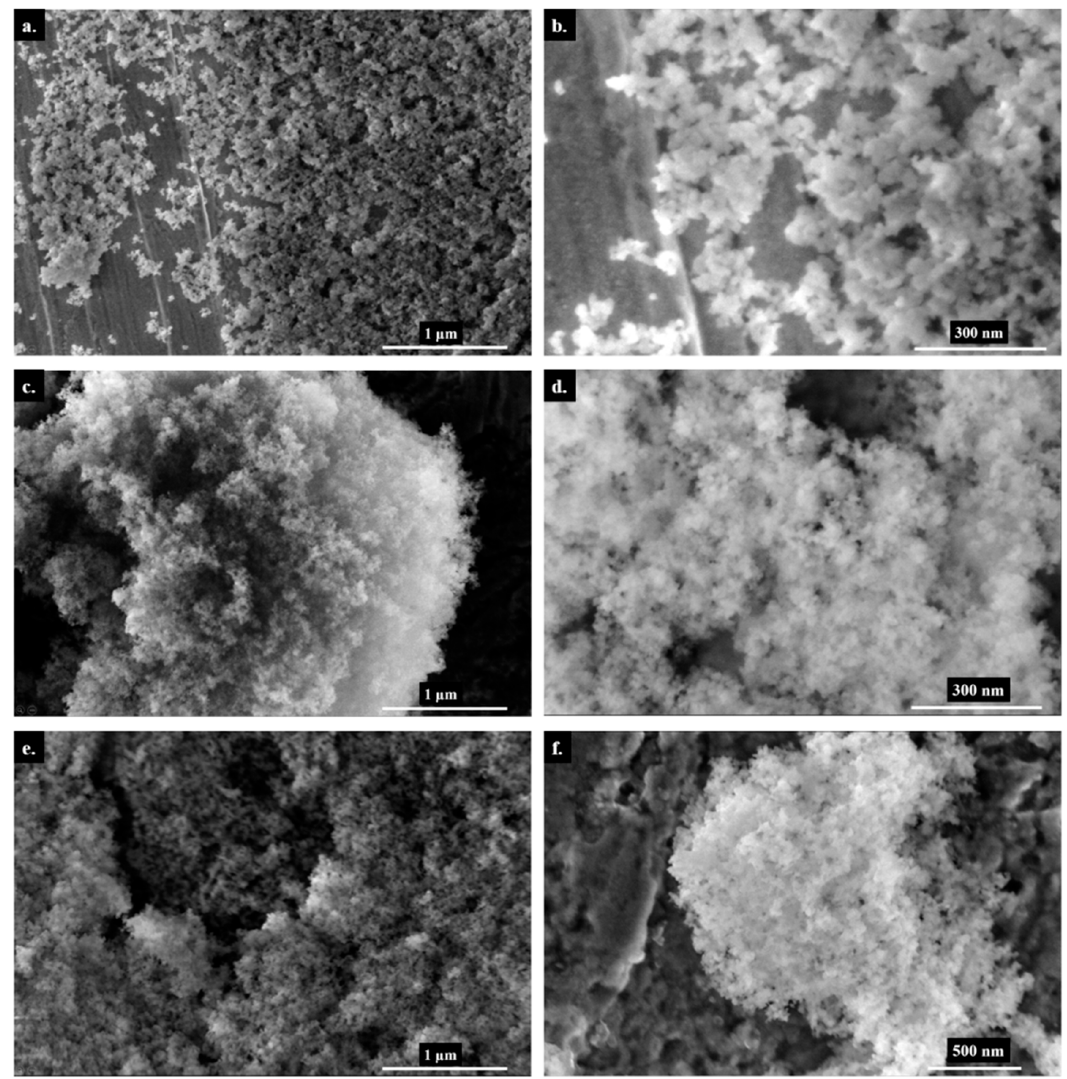
Figure 1. Scanning Electron Microscopy images of silica particles—Non-treated ( a , b ), DBU − loaded ( c , d ) and NaH − loaded ( e , f ). 29 Si ssNMR confirms a chemical reaction between silica and sodium hydride NaH.